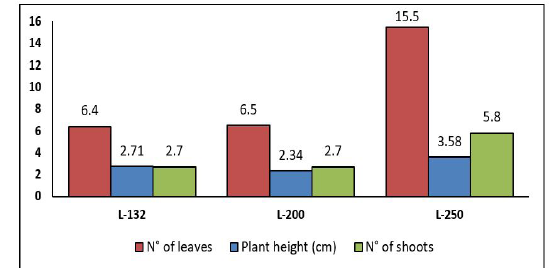
Figure 5. Effect of growth regulators on shoot growing of thorny artichoke microplants ( Cynara scolymus L.) with different growth regulators during 45 days of rooting stage.